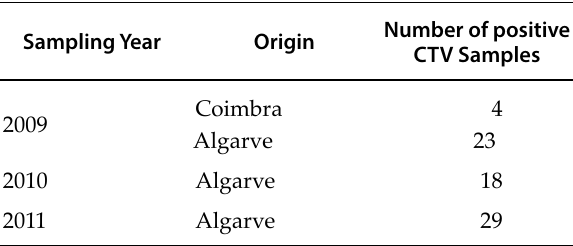
Table 1. Origin and sampling year of positive CTV samples